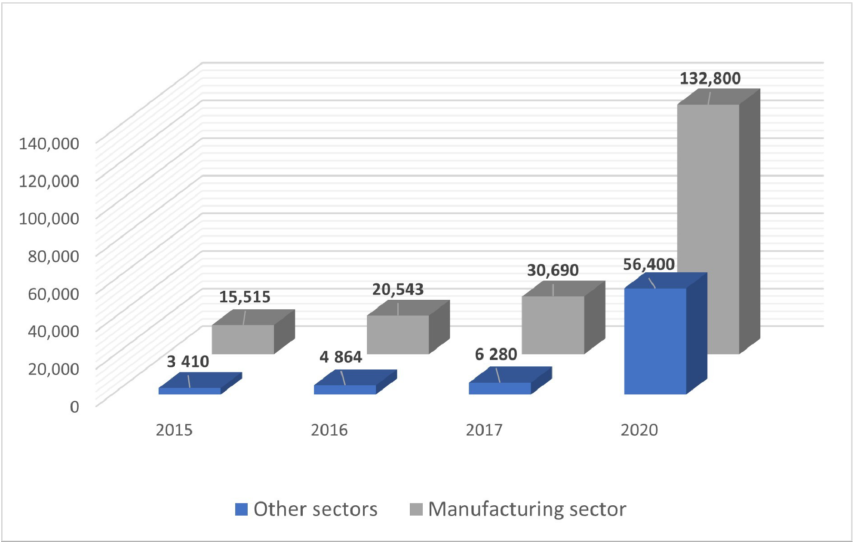
Figure 1. The number of mobile robots used in industry